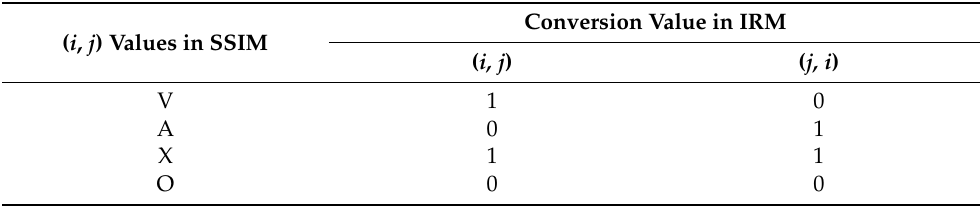
Table 5. Conversion rule for transferring SSIM into an initial matrix of reachability (IMR). ( i , j ) Values in